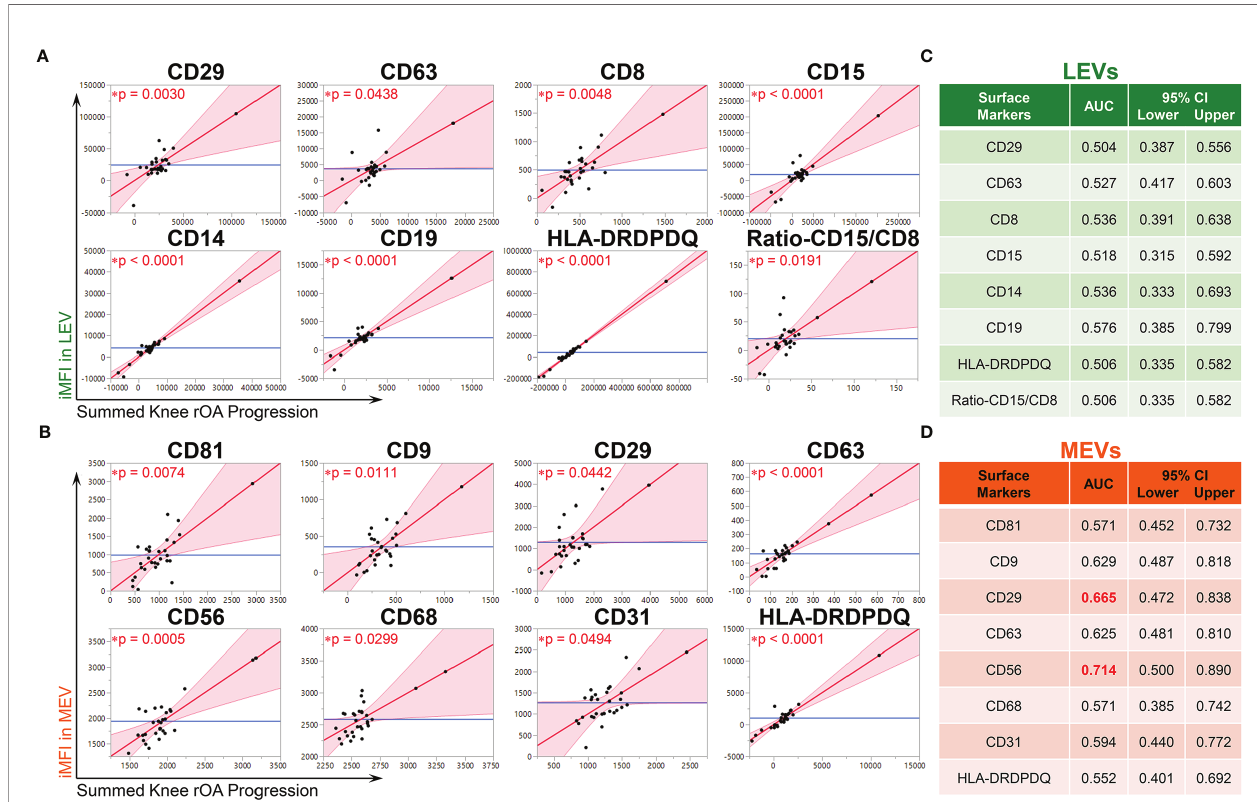
FIGURE 1 | Multiple immune cell-associated LEVs and MEVs at baseline were associated with knee radiographic (r)OA progression. Plasma EVs from OA participants (n = 30, 53% OA-NP and 47% OA-P) at baseline were pro fi led with the indicated surface markers by high resolution multicolor fl ow cytometry. (A, B) Multivariable linear regression modeling was performed with adjustment for the baseline clinical variables (age, gender, BMI and summed knee OA K/L score) to identify the associations of the knee OA radiographic severity changes from baseline to follow-up with the baseline iMFI of each surface marker in gated LEVs, MEVs or SEVs. The Leverage Plots represent plots of leverage of summed knee rOA progression (x axis, scaled in units of the response) vs the baseline iMFI (y axis) of the indicated surface markers in LEVs (A) and MEVs (B) with an asterisks indicate the p < 0.05. No SEV subpopulations based on EV surface markers were associated with knee rOA progression. (C, D) Multivariable logistic regression and ROC curve analysis were used to assess AUC of the knee rOA progression- associated surface markers in LEVs (C) and MEVs (D) to predict progression of radiographic knee OA. Since all tested surface markers in SEVs were not signi fi cantly associated with knee rOA progression, they were excluded from ROC analysis. AUC > 0.5 was considered validated and AUC > 0.65 (red font) was considered a moderate discriminant capability. 95% bias-corrected con fi dence intervals (CIs) for AUCs are reported. LEVs, large EVs; MEVs, medium EVs; iMFI, integrated mean fl uorescence intensity. *p <